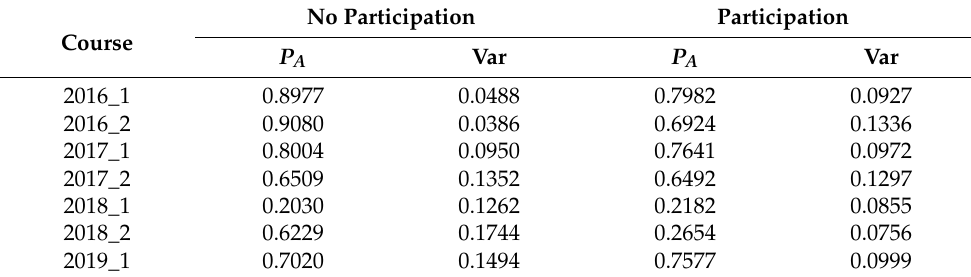
Table 8. Academic performance indicator by semester and participation.